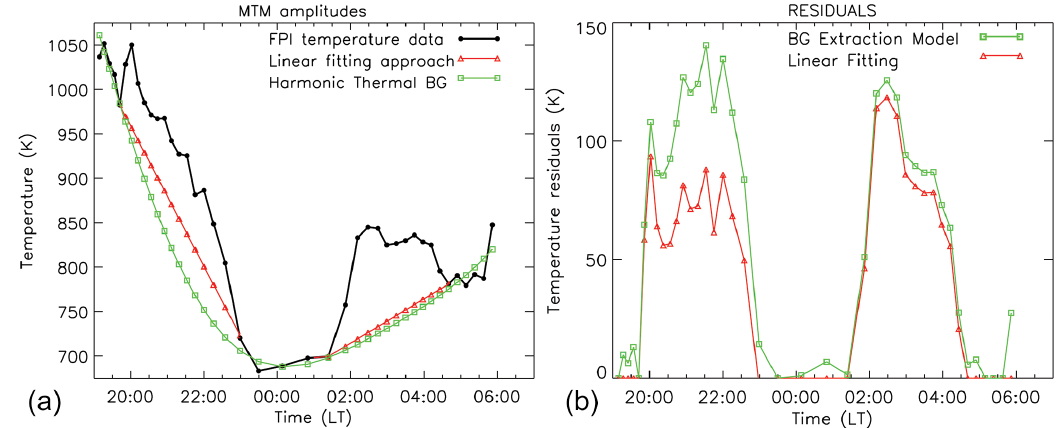
Figure 2. (a) An example of the double MTM structure (black points) and two continuum thermal backgrounds assumed (linear and har- monic) for estimating the MTM amplitude (data for 31 August 2013). (b) Difference plots determined by subtractions of the background linear fit (red) and the harmonic fit (green) from the data points,